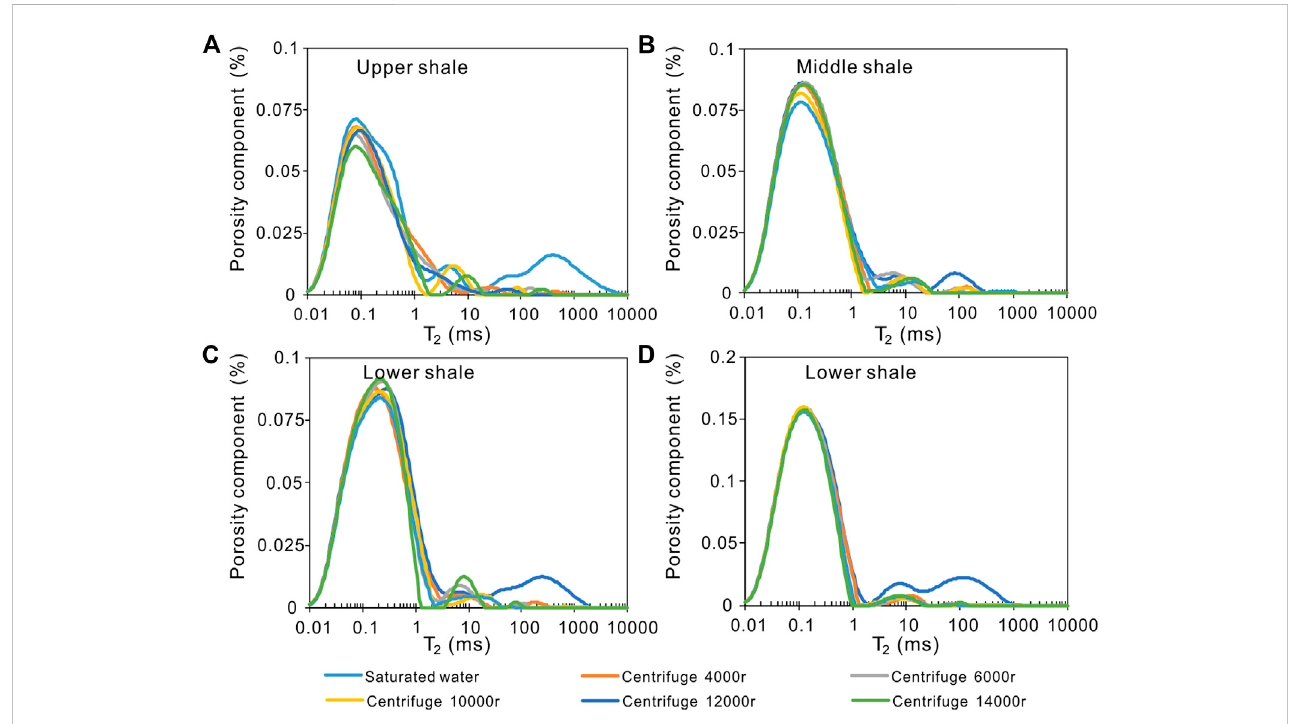
FIGURE 3 NMR T 2 spectra of Shan 2 3 Submember transitional shale under different centrifugation conditions.